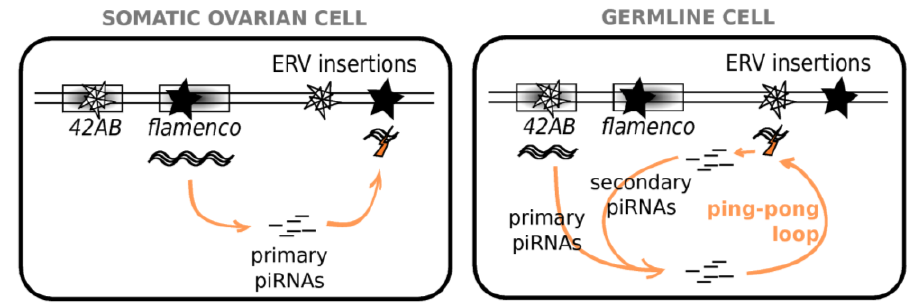
Figure 2. piRNA Pathways in Ovarian Cells. In somatic ovarian cells, clusters, such as flamenco , produce long transcripts, which are processed into primary piRNAs. These piRNAs then trigger the degradation of transcripts of the corresponding TE/ERV families, wherever copies may be integrated in the genome. In germline cells, clusters, such as 42AB produce transcripts, which are processed into primary piRNAs. These piRNAs then trigger the degradation of transcripts of the corresponding TE/ERV families into piRNAs, which trigger the degradation of antisense transcripts also produced by clusters. This generates antisense secondary piRNAs, which are able to target TE/ERV transcripts. Such a phenomenon, called “ping-pong loop”, allows amplification of the